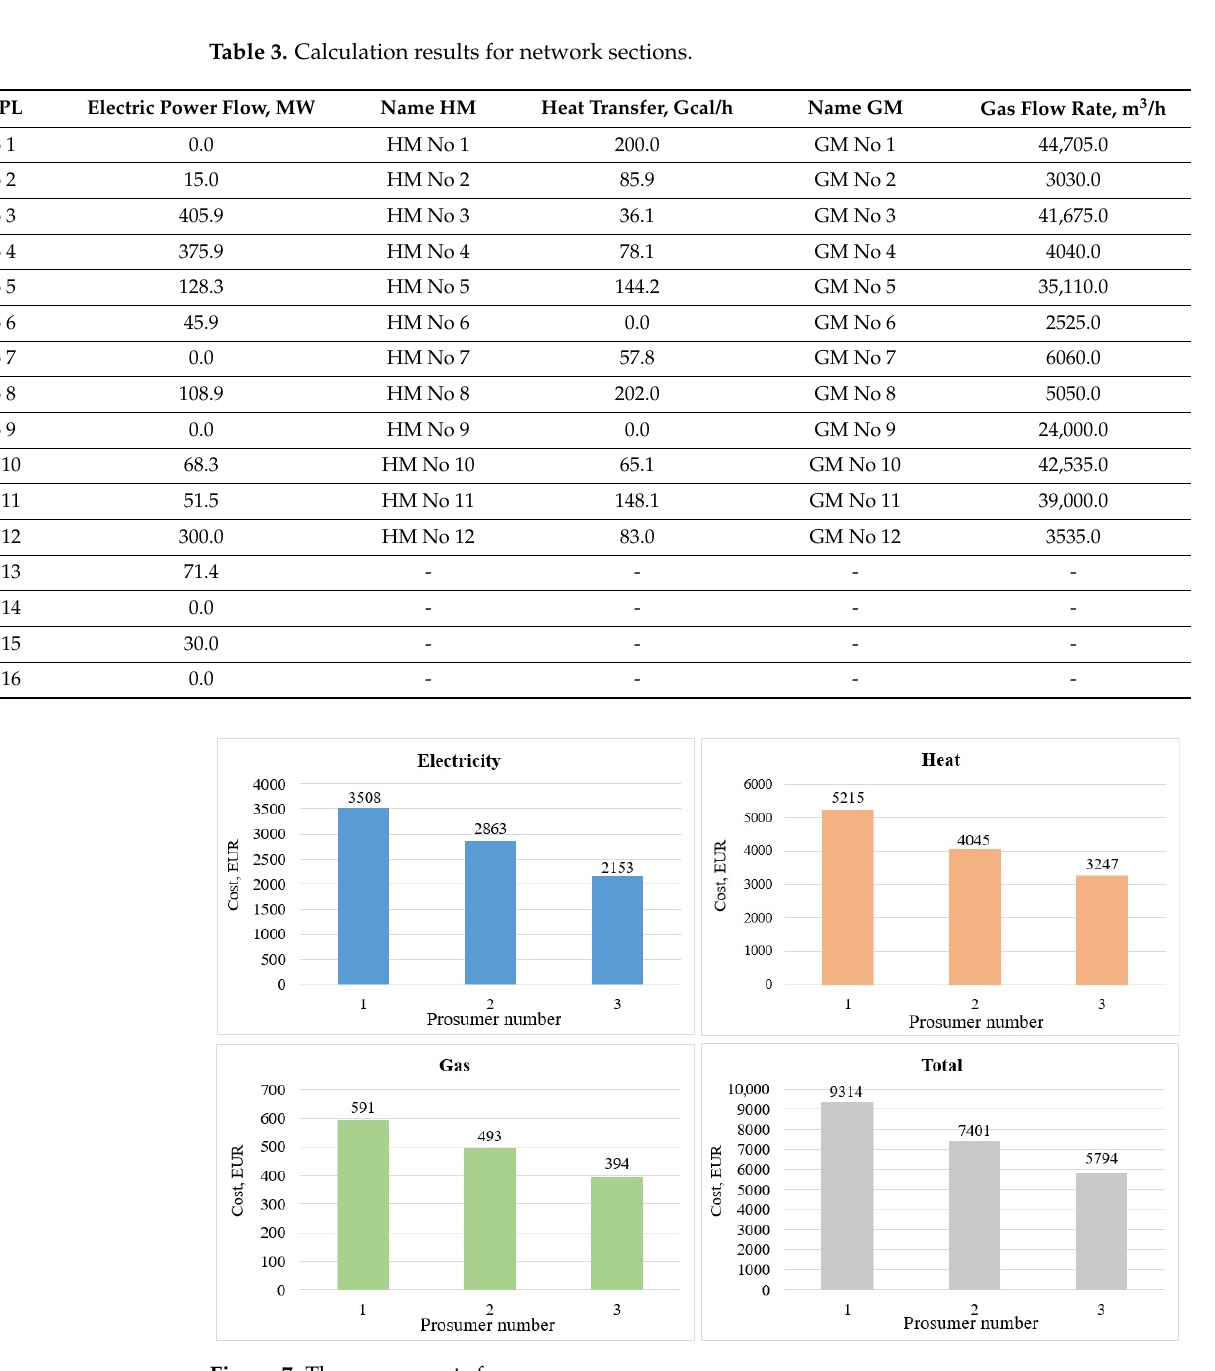
Figure 7. The energy costs for prosumers.